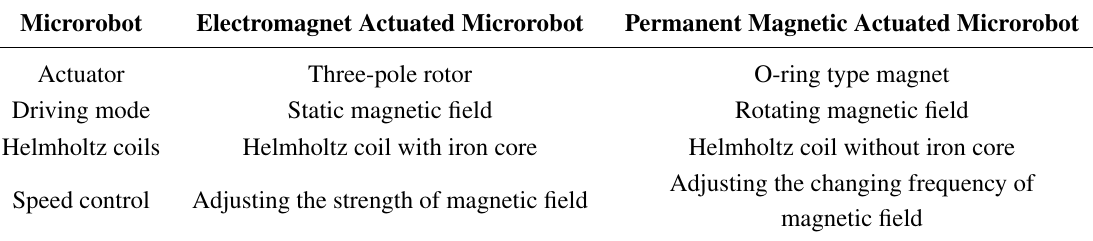
Table 2. Performance of magnetic actuated microrobot.